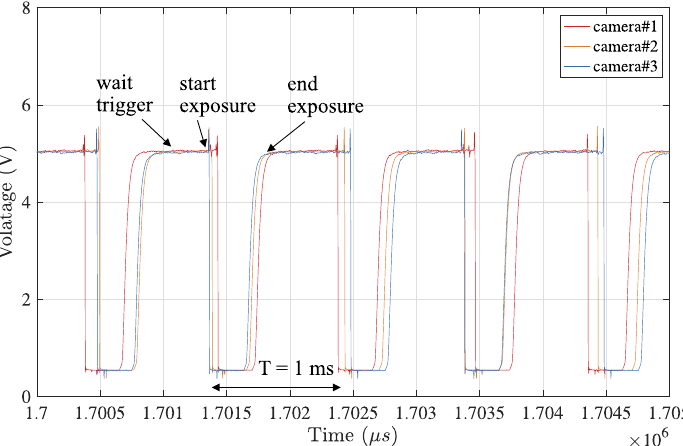
Figure 8. Frame synchronization captured by logic analyzer. The event times indicating exposure start and end in all cameras are monitored, where logically low state ( < 2 V) indicates that image capturing is in progress. These times are regarded as the ground truth for the evaluation of the actual frame synchronization.